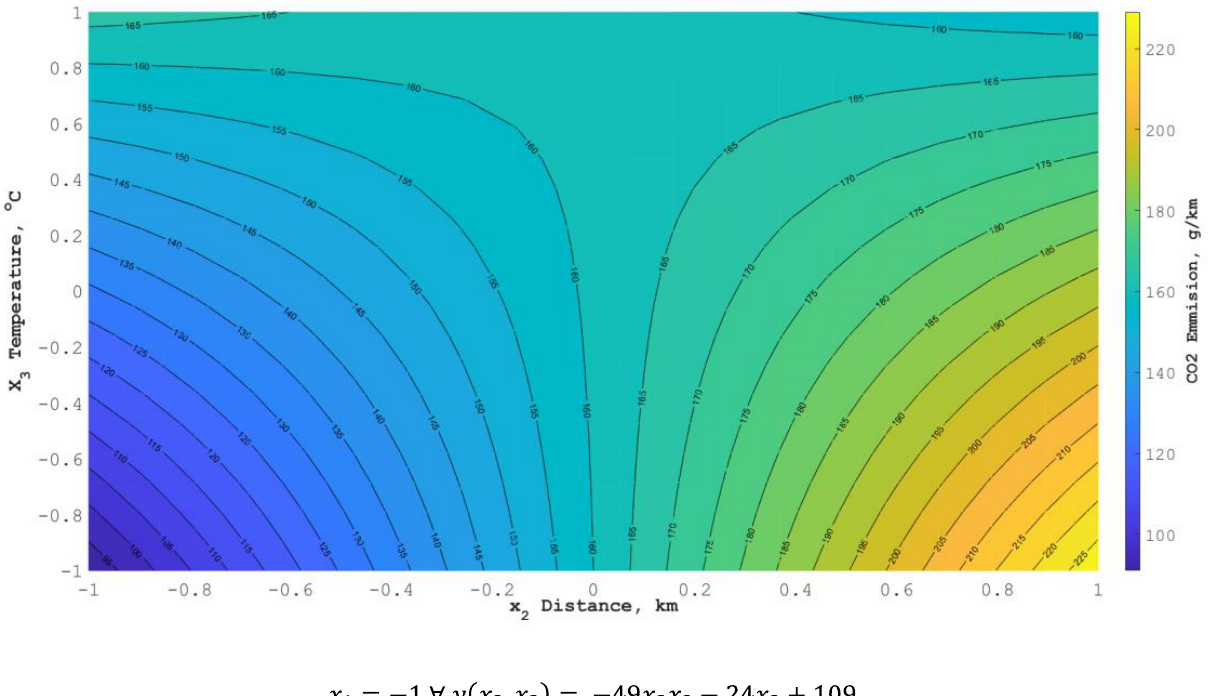
Figure 11. Change in CO 2 emissions depending on the variability of factors x 2 and x 3 for a vehicle (EV) moving for 30 min (x 1 = − 1).